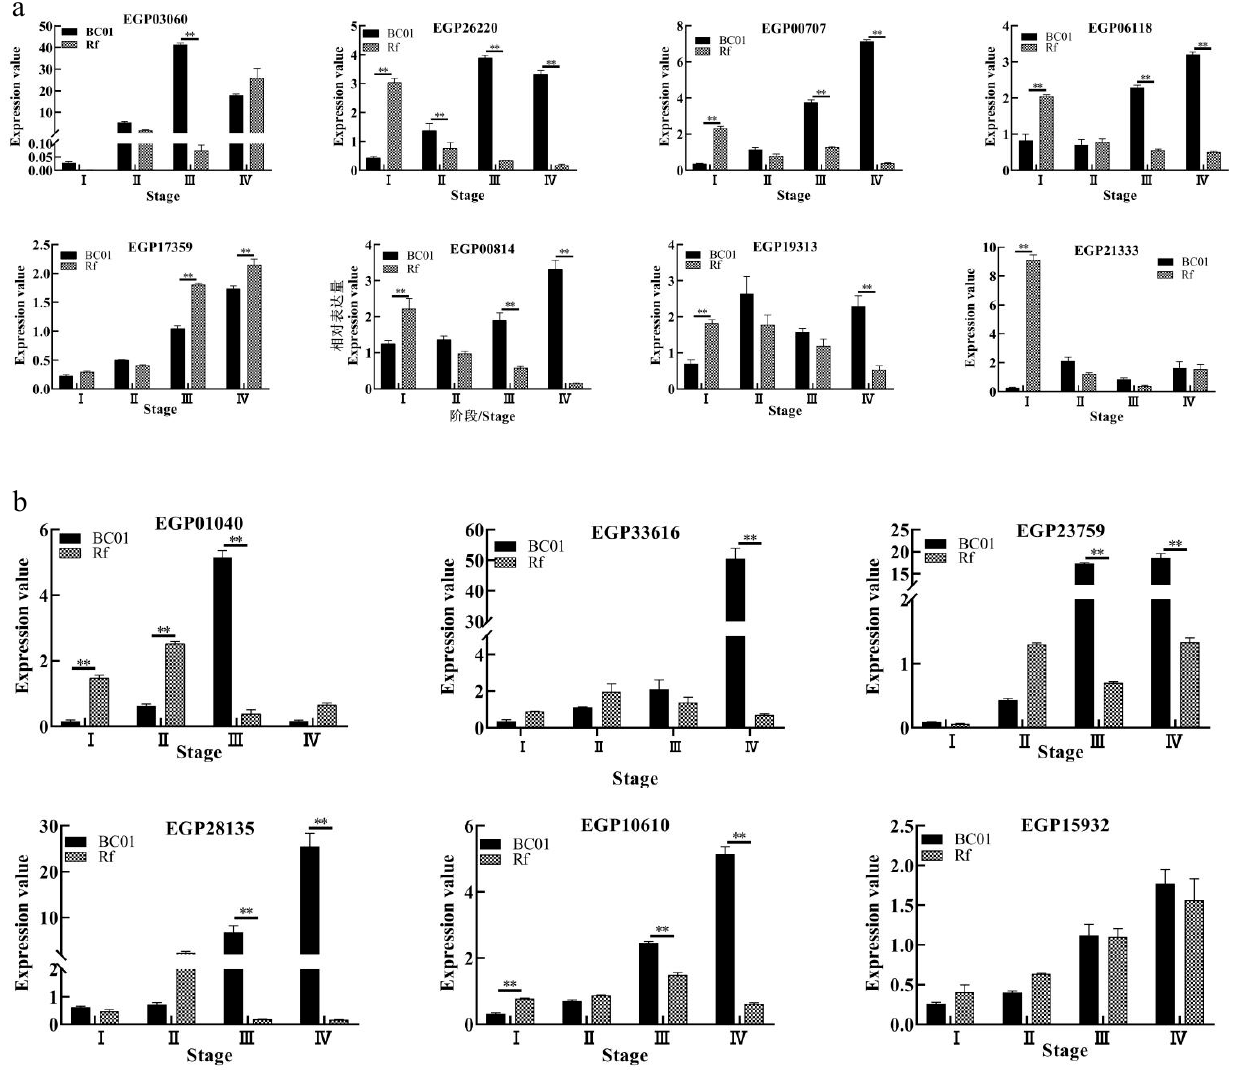
Figure 7. Expression analysis of candidate genes screened under WGCNA. ( a ) A total of 8 candidate genes were selected from root transcriptome results and verified by qPCR in root tissues. ( b ) A total of 6 candidate genes were selected from stem transcriptome results and verified by qPCR in stem tissues. The bar plots and error bars represented averages and standard errors for three repeated samples under t -test. I, uninoculated; II, 1 day post-inoculation; III, early disease onset; IV, peak of disease onset. Note: ** indicates significance at the 0.01 level.